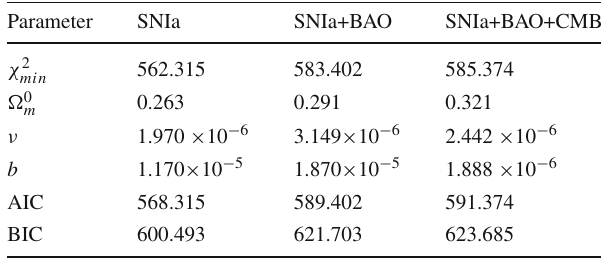
Table 1 Summary of the observational constraints for the free param- eters and for the case of ν = b = 0 ( (cid:3) CDM with two free parameters) Parameter